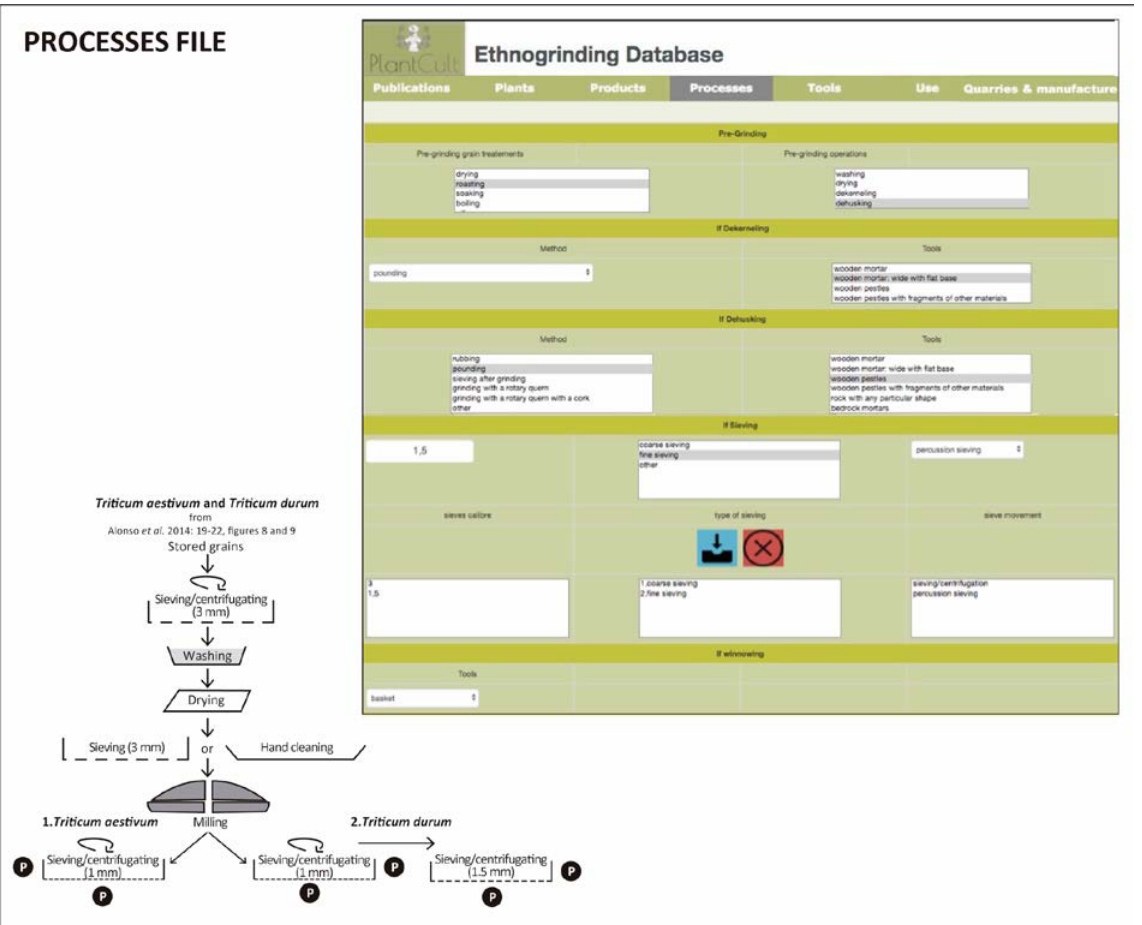
Figure 5. The Processes tab and an operational sequence of processing naked wheats according to Alonso et al .